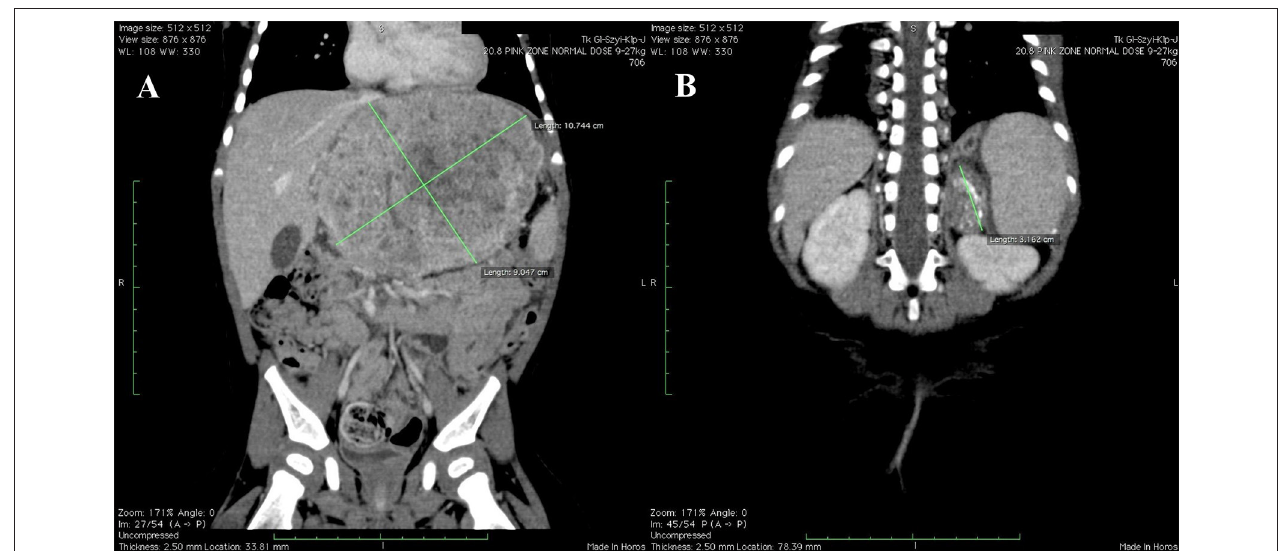
FIGURE 1 | Initial CT scans. (A) Hepatoblastoma of the left hepatic lobe measuring 11 × 6.5 × 8.9cm. (B) Neuroblastoma of the left adrenal gland measuring 2.3 × 1.6 × 3.6cm.